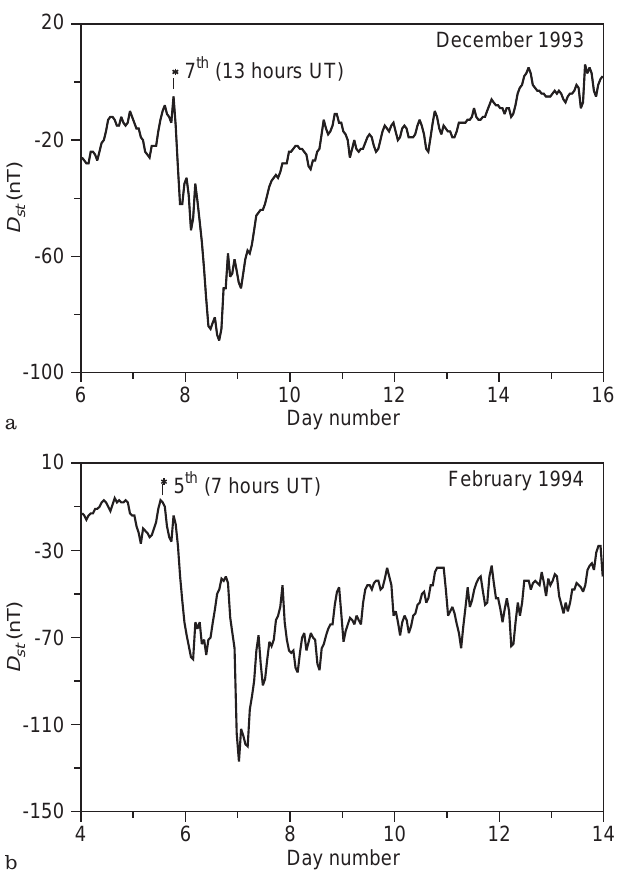
Fig. 1a,b. Variation of Dst index for the periods under study during a December 1993, b February 1994